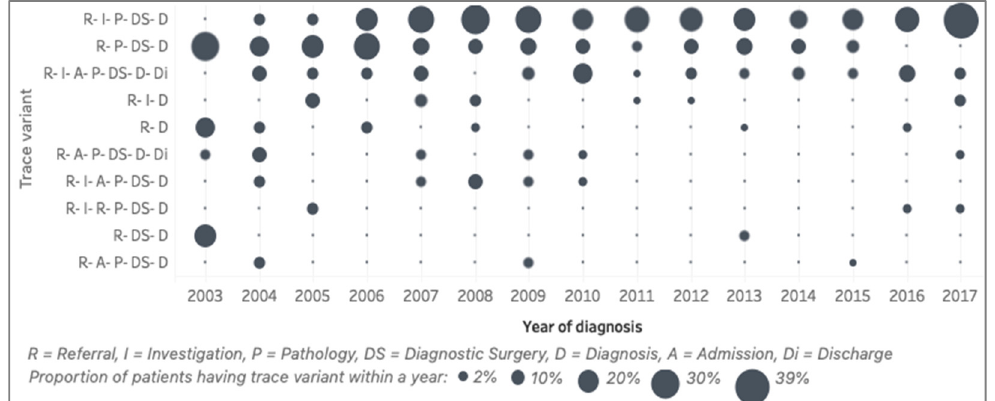
Figure 6 . Summary of the trace variant comparison (2003–2017). Size represents the percentage of trace variants over the number of patients diagnosed in each year.